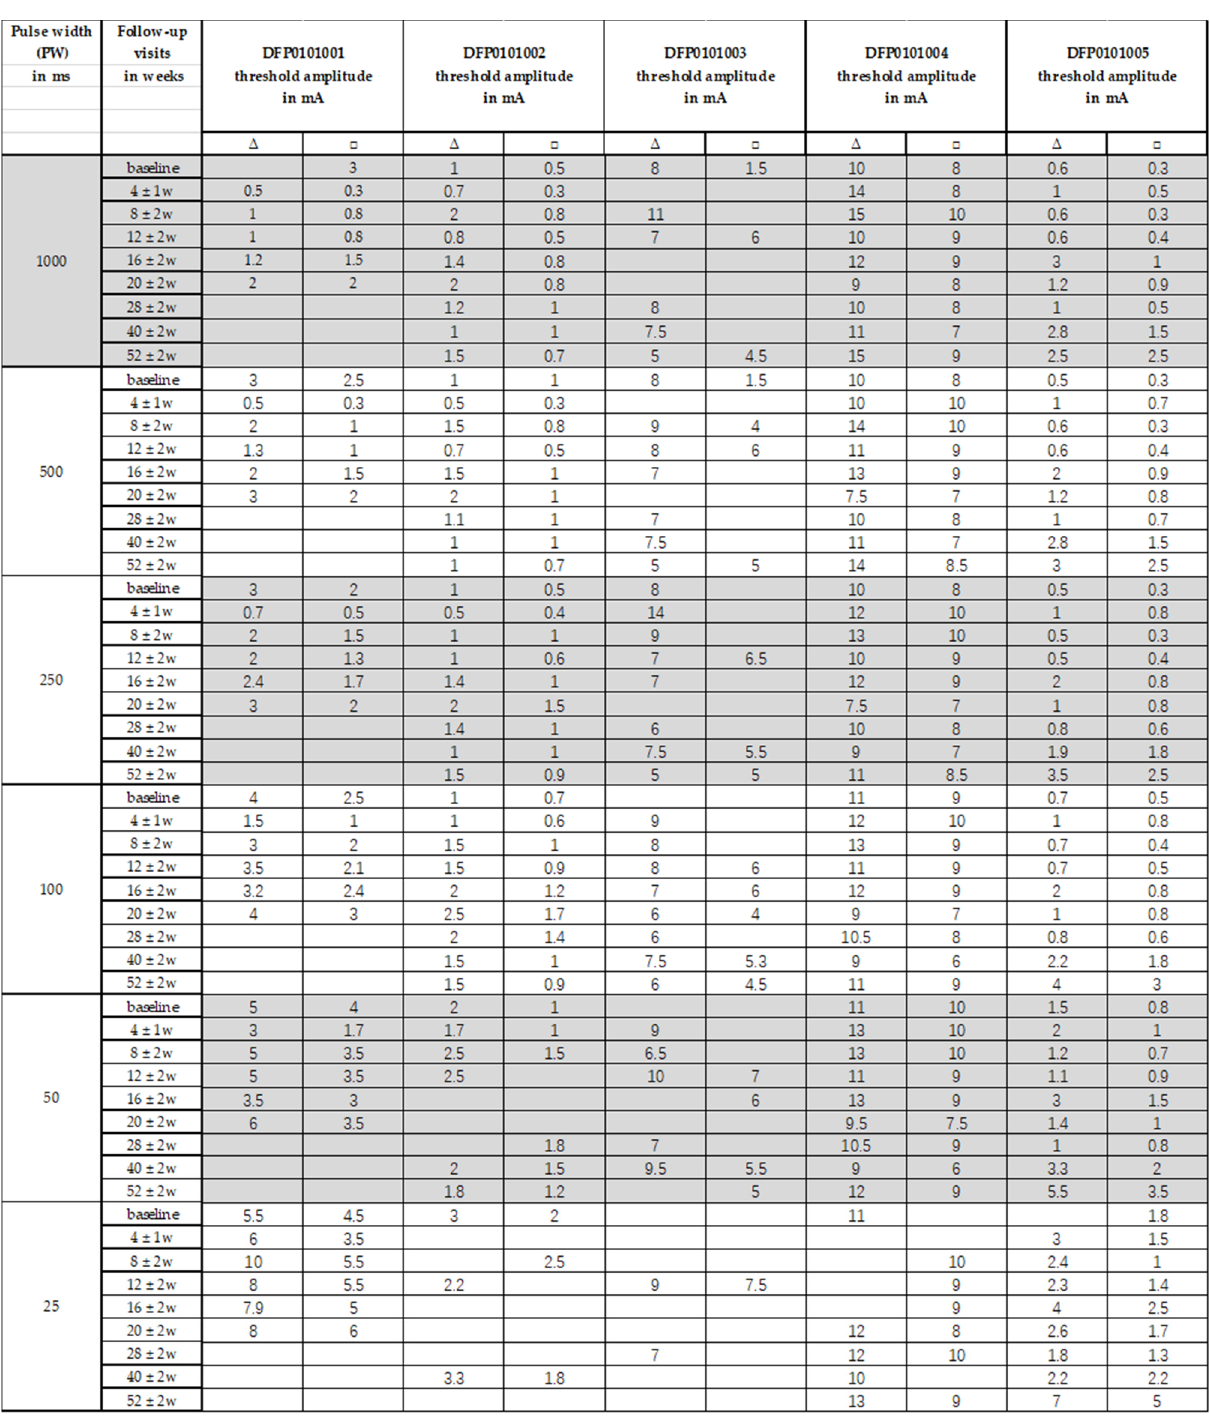
Figure 6. Over time changes in the threshold amplitude required to observe a selective ZYG response without unspecific activation of other facial muscles and/or pain/discomfort for evaluated PWs between 1000 ms and 25 ms with stimulations delivered with a triangular ∆ or a rectangular □ waveform.